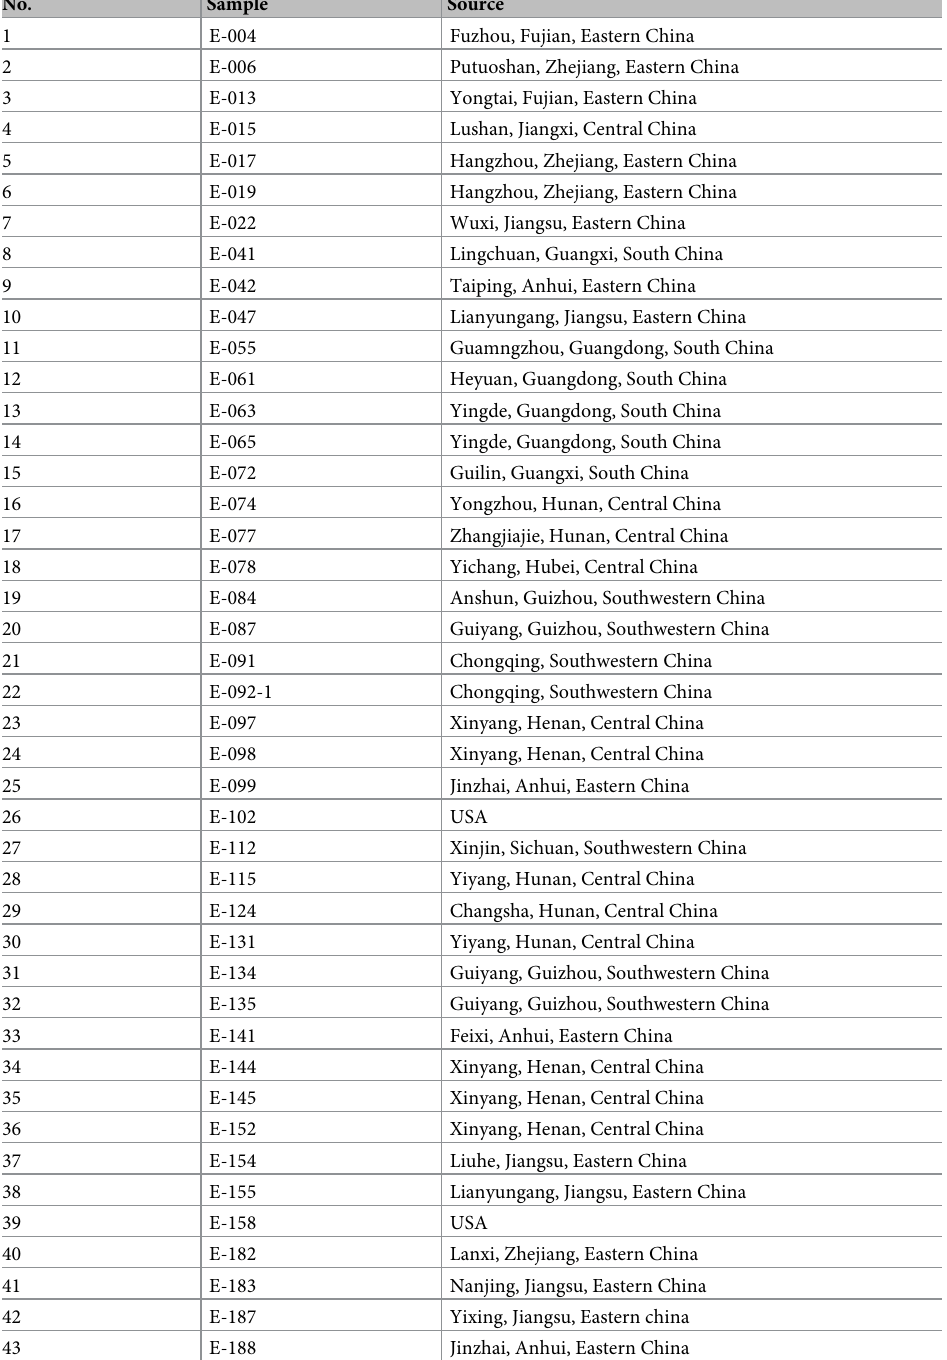
Table 1. The germplasm collections of E . ophiuroide used in this study. No.